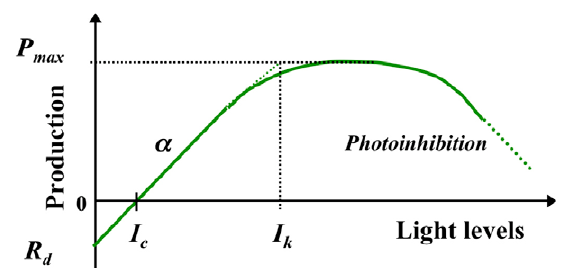
Fig. 1. – Theoretical representation of a photosynthesis/irradiance curve and the corresponding photosynthetic parameters: photosyn- thesis at saturation (P ), light at saturation (I ), light at compensa- max k tion (I ), photosynthetic efficiency ( α ) and dark respiration (R c d